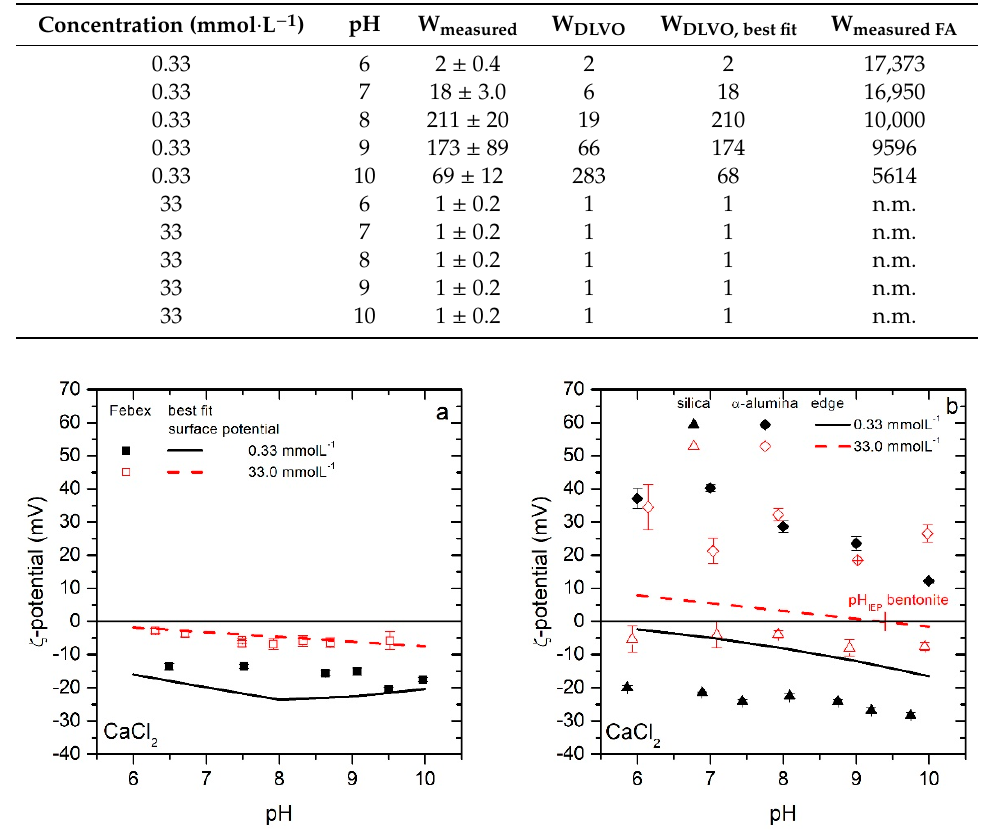
Table 1. Measured stability ratio W measured with and without addition of 1 mg L − 1 DOC (GoHy-573 fulvic acid, FA) for CaCl 2 electrolyte solution. Theoretical W DLVO values calculated with Equation (6) and W DLVO, best fit values derived from fitting the surface electrokinetic potential of the FEBEX bentonite colloid (see lines in Figure 5a).